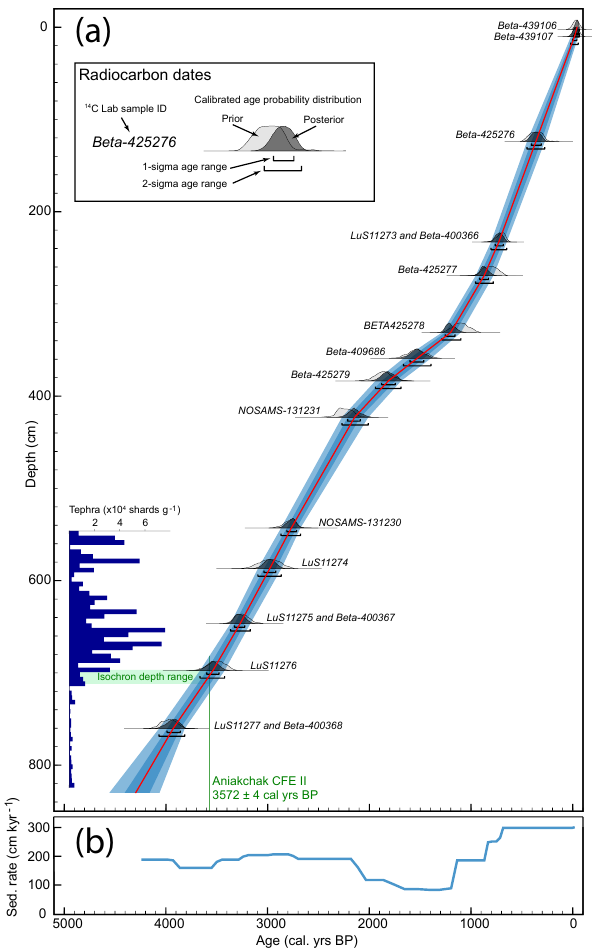
Figure 6. Final age–depth relationship (a) and sedimentation rates (b) of Core 2PC based on 17 radiocarbon dates (values in Ta- ble 1), using a (cid:49)R = 477 ± 60 years. In (a) , the red line shows the median age and the dark- and light-blue shading show the 1 σ and 2 σ age ranges,